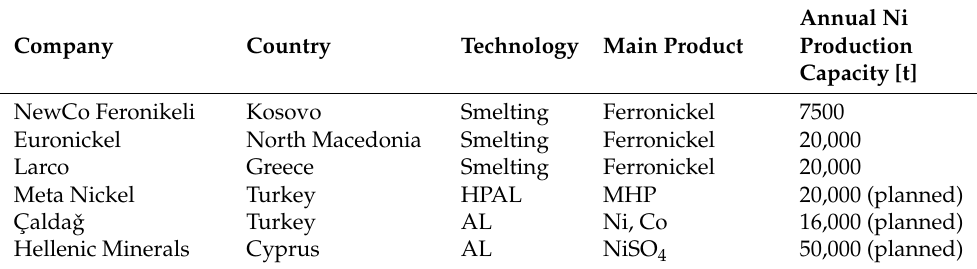
Table 4. Industrial facilities for processing of laterites in the SEE and Turkey region. Data presented in Figure 4 are collected from the official corporate